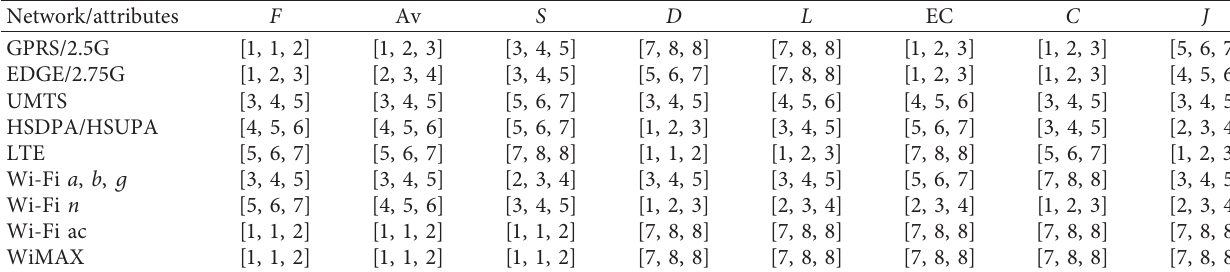
Table 9: The fuzzy decision cell filled with the corresponding fuzzy